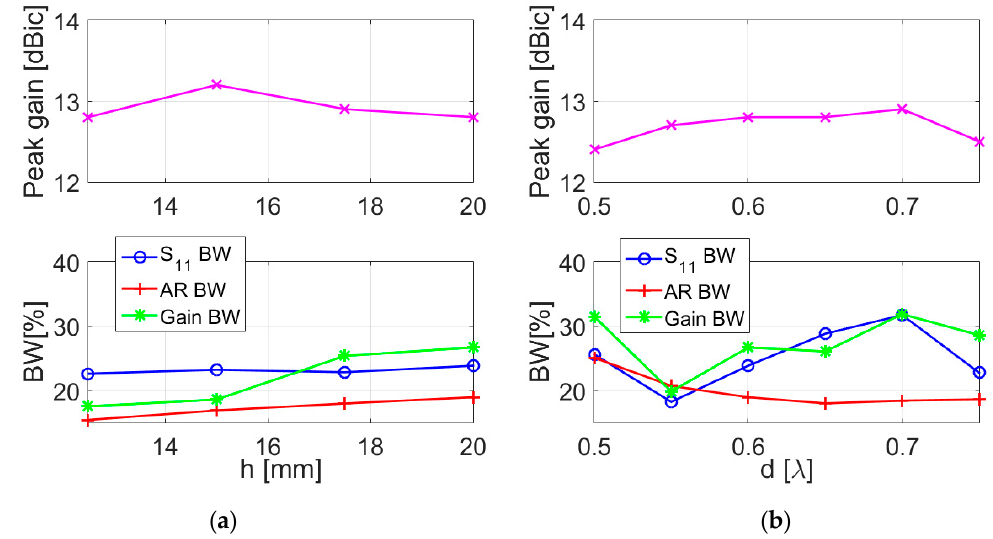
Figure 6. Normalized bandwidth (BW) and broadside LHCP peak gain simulation results: ( a ) as a function of h and ( b ) as function of d .